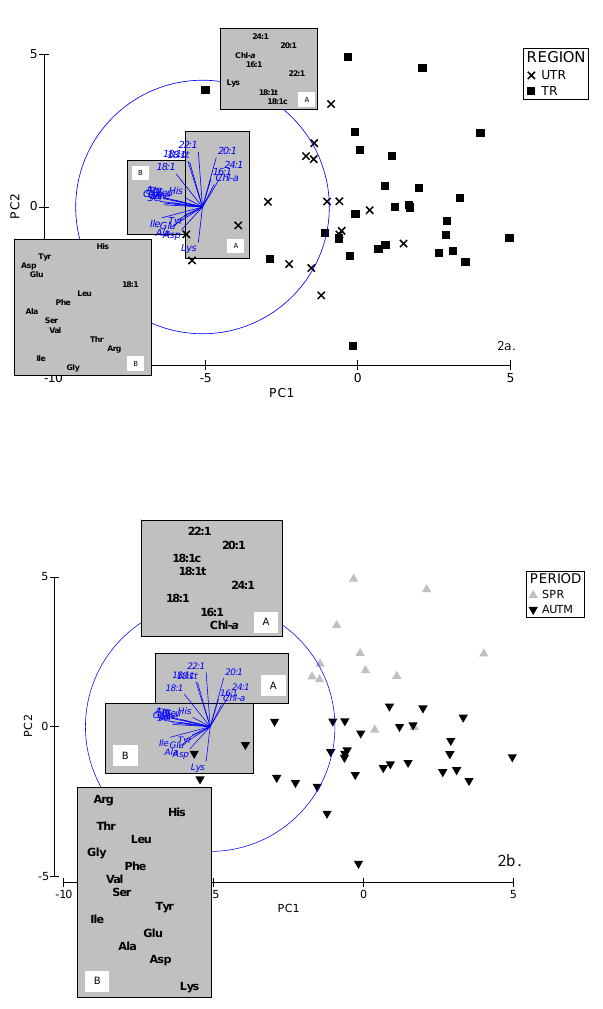
Fig. 2. Representation of the multivariate statistical test PCA car- Figure 2 ried out on those biomarkers which better evidenced differences be- tween sampling seasons (Chl a and MUFA) and between trawled and untrawled regions (protein and neutral THAA). In (a) , stations located in the untrawled and the trawled regions are evidenced, whereas in (b) , stations are distinguished based on the sampling season – spring or autumn. Biomarkers are shown in both plots (a) and (b)